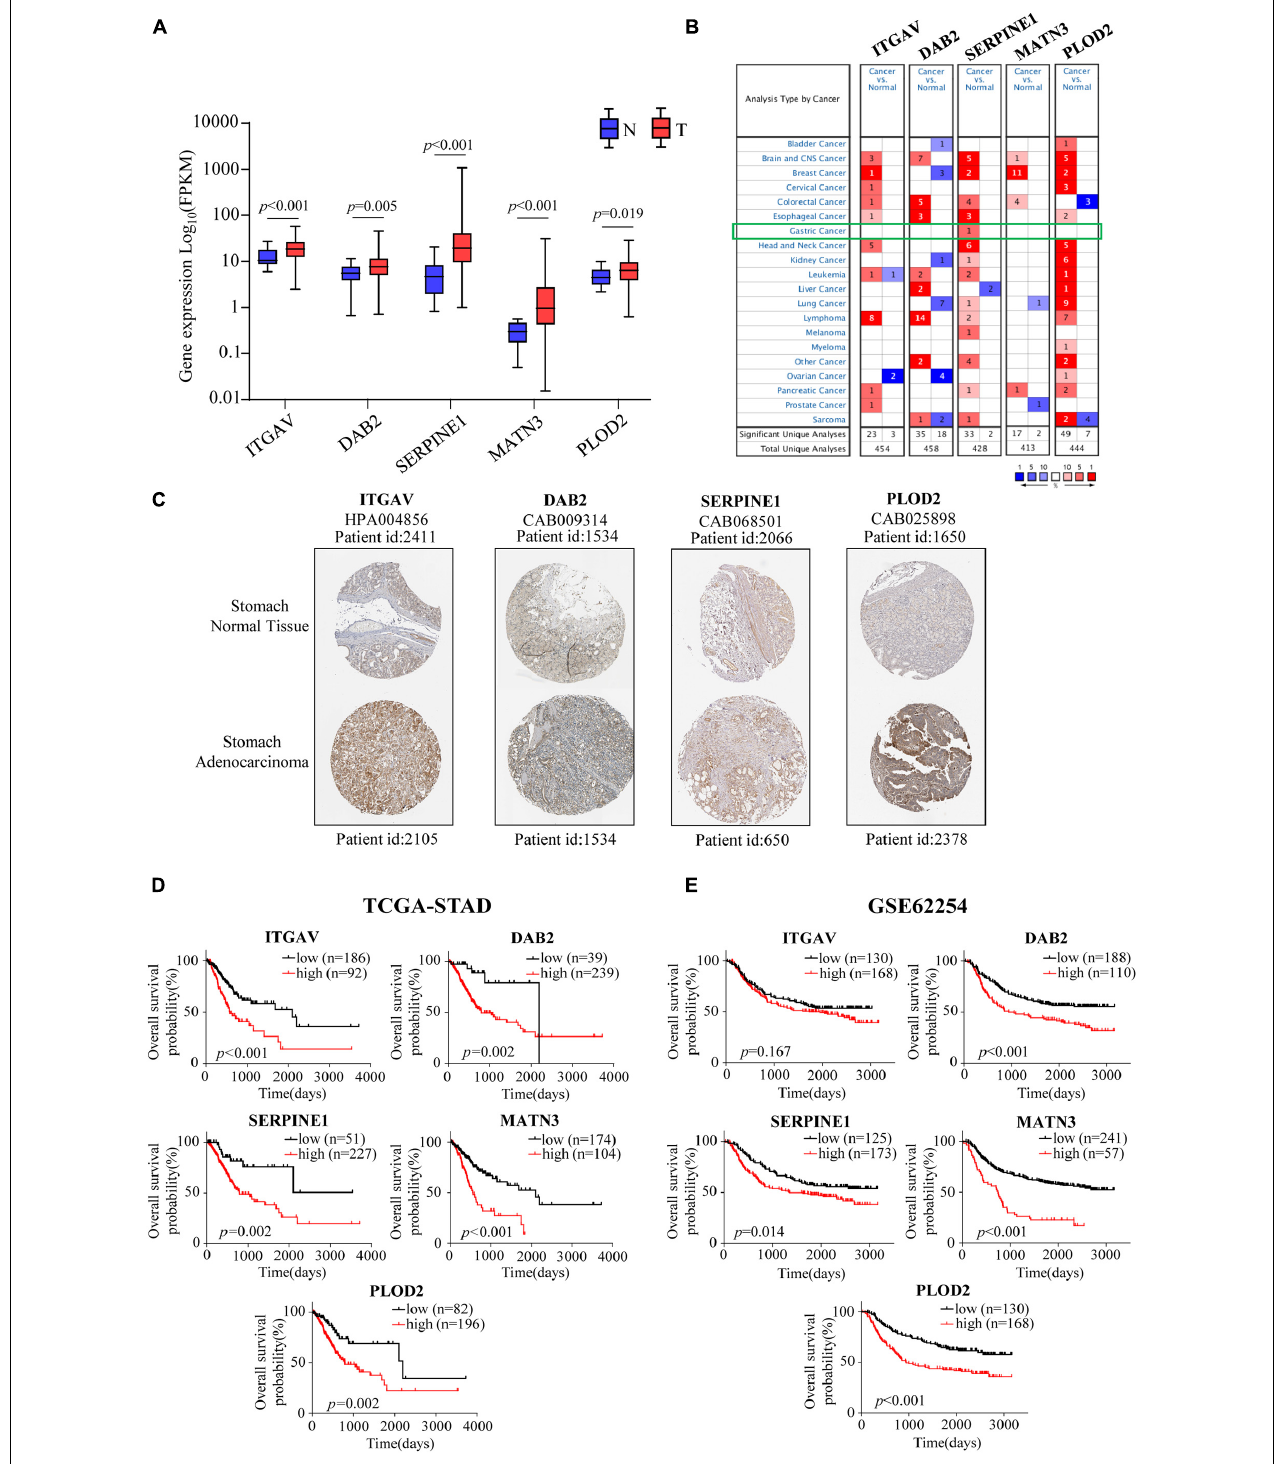
FIGURE 5 | Expression profiles, Kaplan-Meier analyses of EMT-related signature members. (A) The mRNA expression profiles of members in EMT-related signature in the TCGA-STAD cohort. (B) Expression profiles of EMT-related signature members in Oncomine database. (C) The protein expression profiles of EMT-related signature members in the Human Protein Atlas database. (D,E) Kaplan-Meier estimates of OS based on EMT-related signature members in the TCGA-STAD cohort (D) and the GSE62254 cohort (E) .